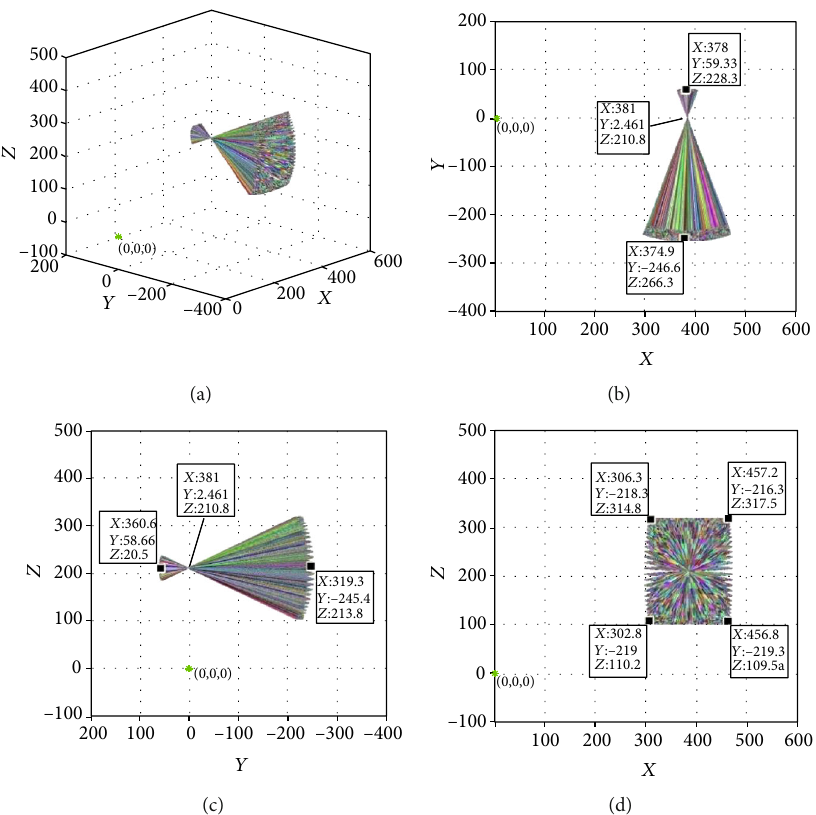
Figure 11: Posture of ultrasonic probe at 60 mm feeding: (a) three-dimensional map; (b) xoy plane projection; (c) yoz plane projection; and (d) xoz plane projection.